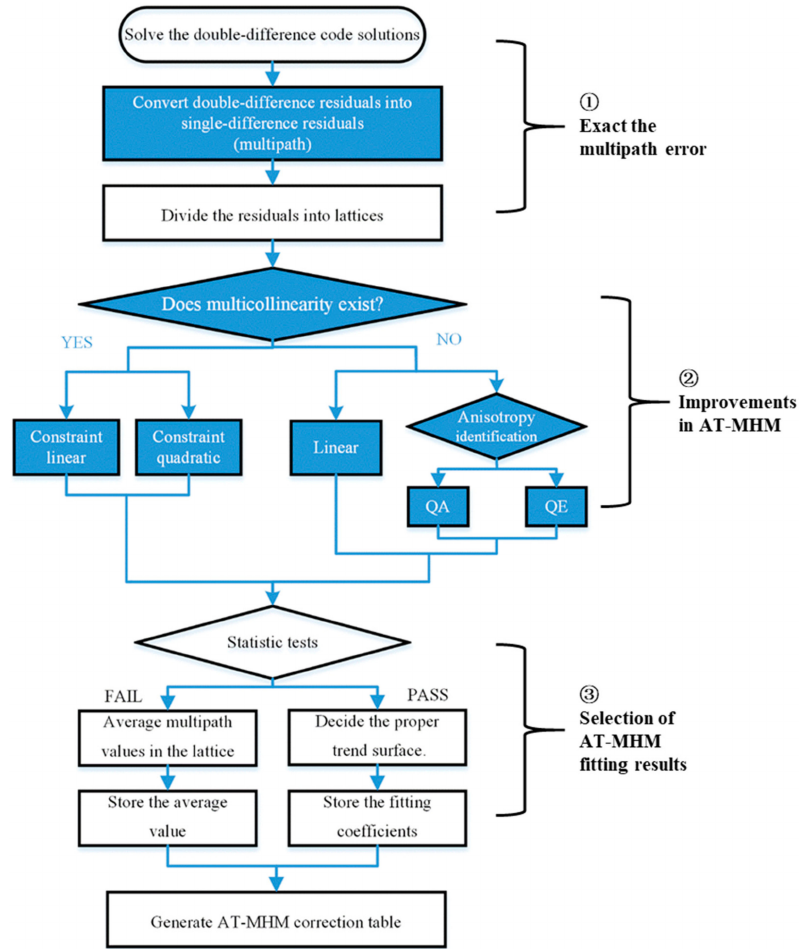
Figure 1. Flow chart of advanced trend surface analysis-based multipath hemispherical model (AT-MHM)